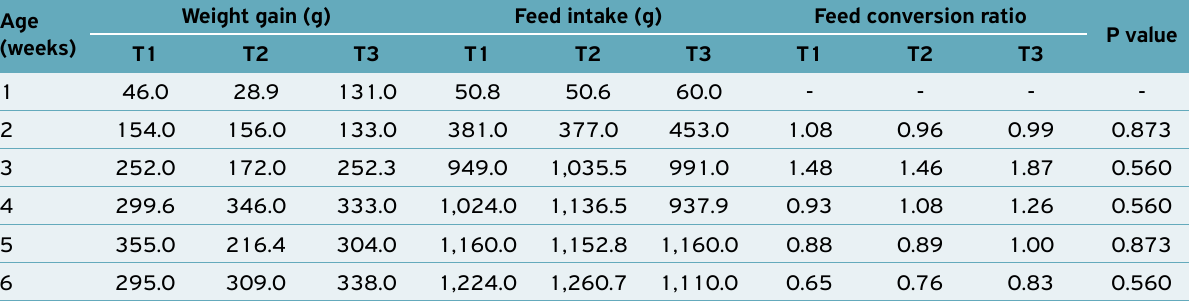
Table 1. Performance of broilers fed with flour burdock (T1); flour burdock with Bifidobacterium (T2) and negative control (T3): Test 1.